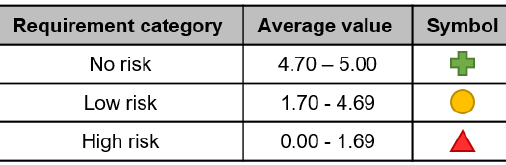
Figure 3. Risk categories of the requirements.